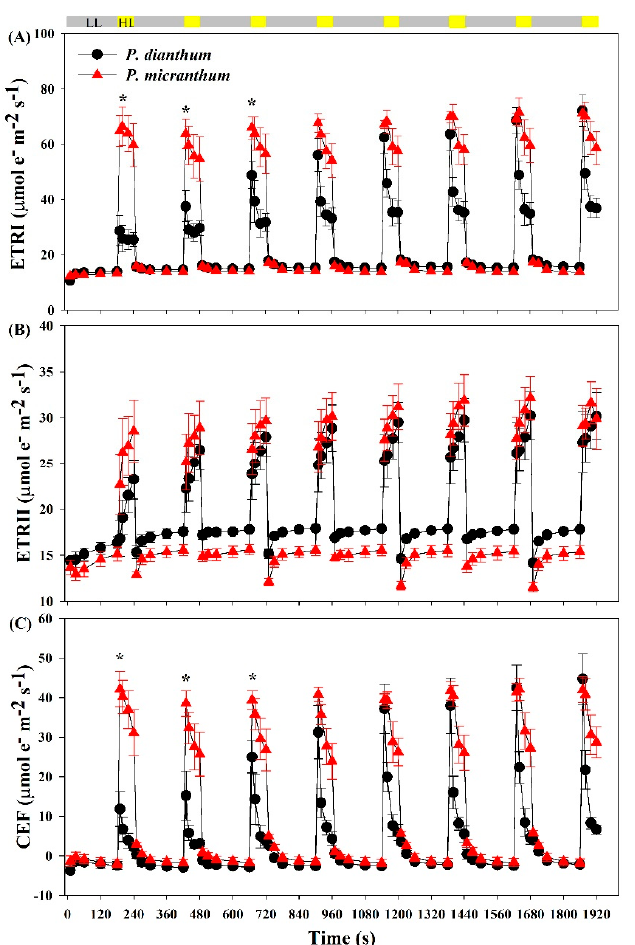
Figure 3. Photosynthetic electron transport of Paphiopedilum dianthum and P. micranthum under fluctuating light. ETRI, rate of photosynthetic electron flow in PSI ( A ); ETRII, rate of photosynthetic electron flow in PSII ( B ); CEF, cyclic electron flow around PSI ( C ). Each data point represents the mean ± SE for five measurements from five individual plants. LL, low light; HL, high light. Asterisks indicate significant differences between P. dianthum and P. micranthum with the t-tests of independent